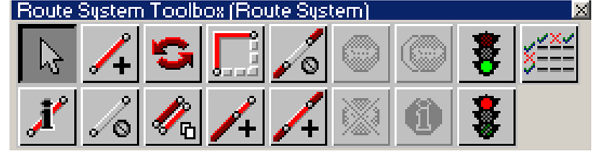
Fig. 4 Toolbox for transit